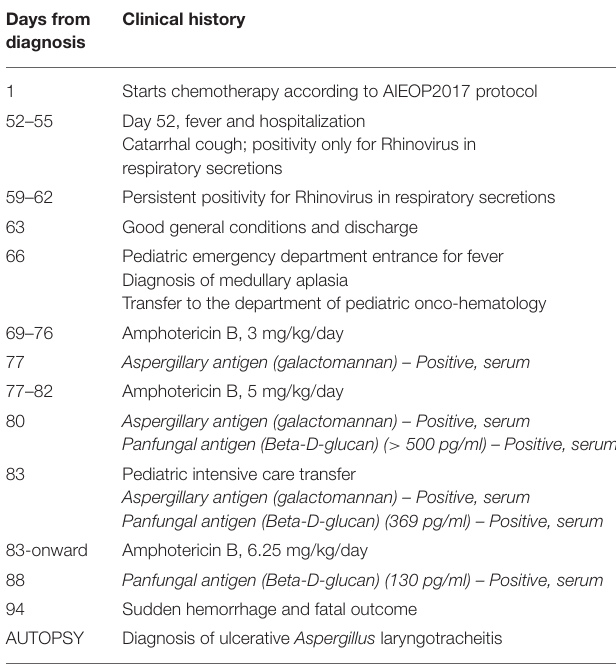
TABLE 1 | Timeline showing the disease course of the patient up to